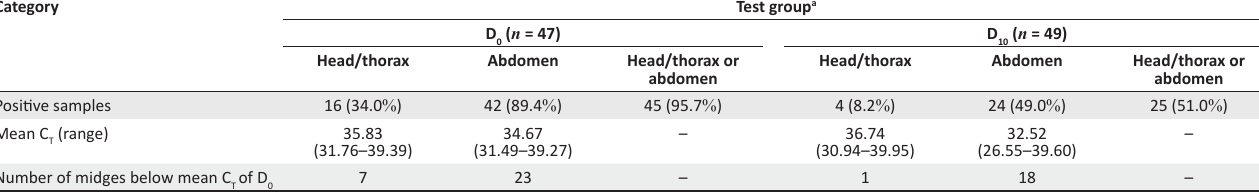
AHSV, African horse sickness virus; C a , One group of midges was dissected on the day of feeding (D